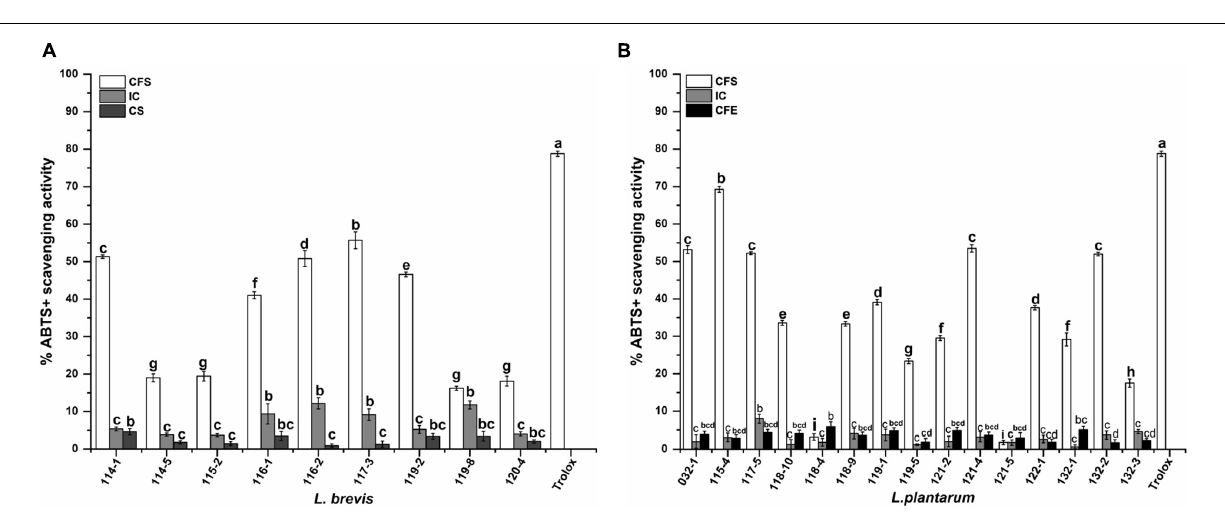
FIGURE 5 | ABTS + scavenging activity of (A) Lactobacillus brevis strains and (B) Lactiplantibacillus plantarum strains isolated from fermented vegetables in Shaanxi, China. Data shown are mean ± SD of triplicate values of independent experiments. Different letters indicate significantly different means ( P <